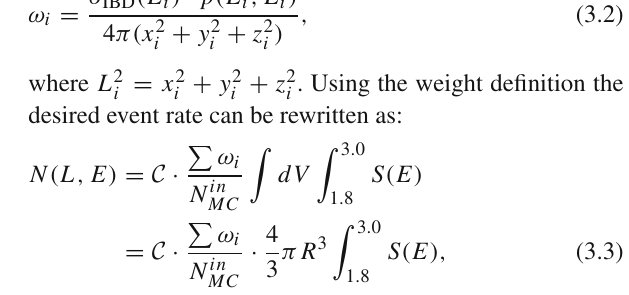
Fig. 2 The schematic layout of the proposed experiment. Two positions for the radioactive source are assumed: at the center (position I) and outside of the detector (position II). Two fiducial volume cuts are applied. Inner cut with radius 100 cm and outer cut with width 70 cm. The yellow area is the active volume for position I, the yellow area plus the inner cut region is active volume for position II. The IsoDAR container is located further outside compared to position II. Only the outer cut is applied for this case